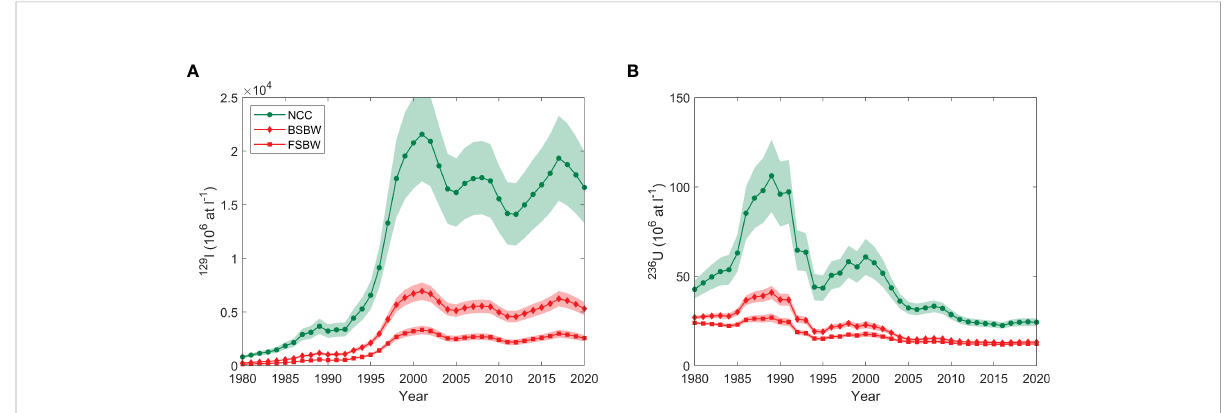
FIGURE 2 Input functions of 129 I (A) and 236 U (B) in the Norwegian Coastal Current (NCC), Barents Sea Branch Water (BSBW), and Fram Strait Branch Water (FSBW) after Casacuberta et al. (2018) and We fi ng et al.